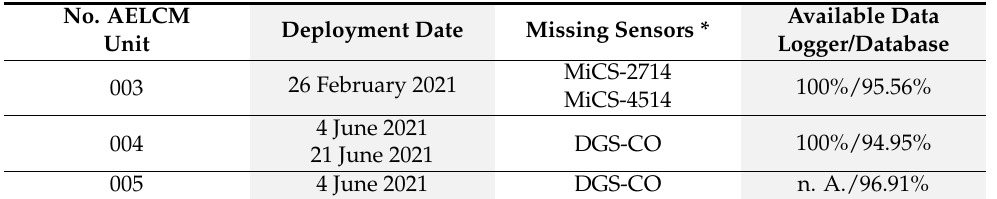
Table 2. General information about the deployed AELCM units’ individual LCS configurations including the amount of available data for the first atmospheric exposure monitoring network (AEMN) experiment for every deployed AELCM unit since their individual deployment